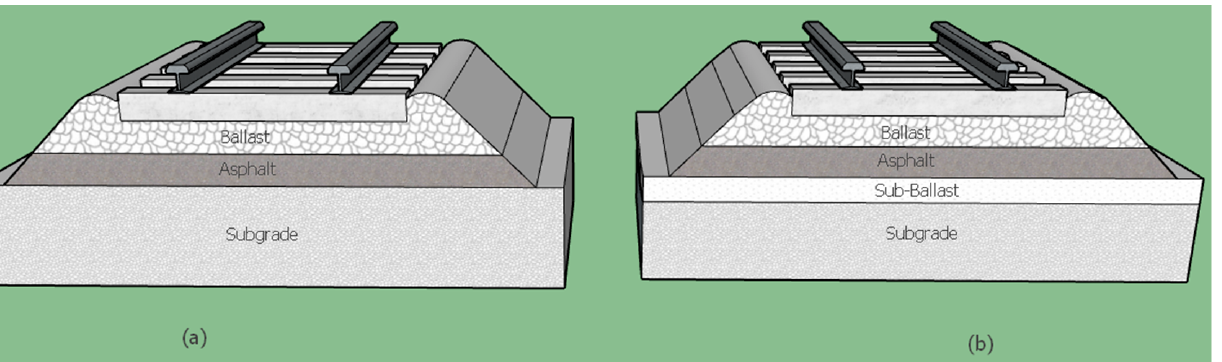
Table 2. Properties of a typical track with asphalt underlayment used in the USA